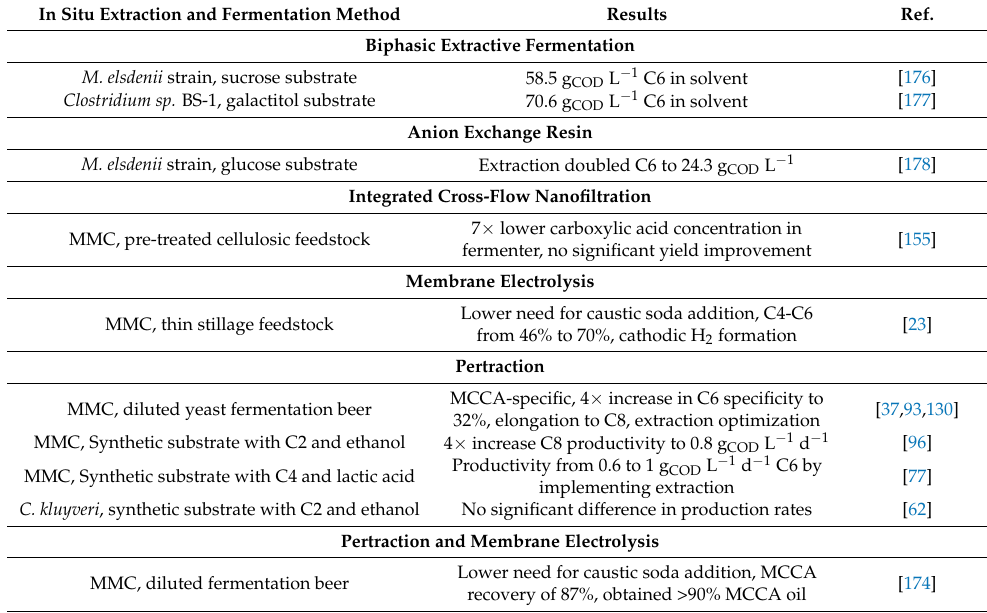
Table 6. Overview of the results of applying in situ extraction in MCCA fermentation experiments. In Situ Extraction and Fermentation Method